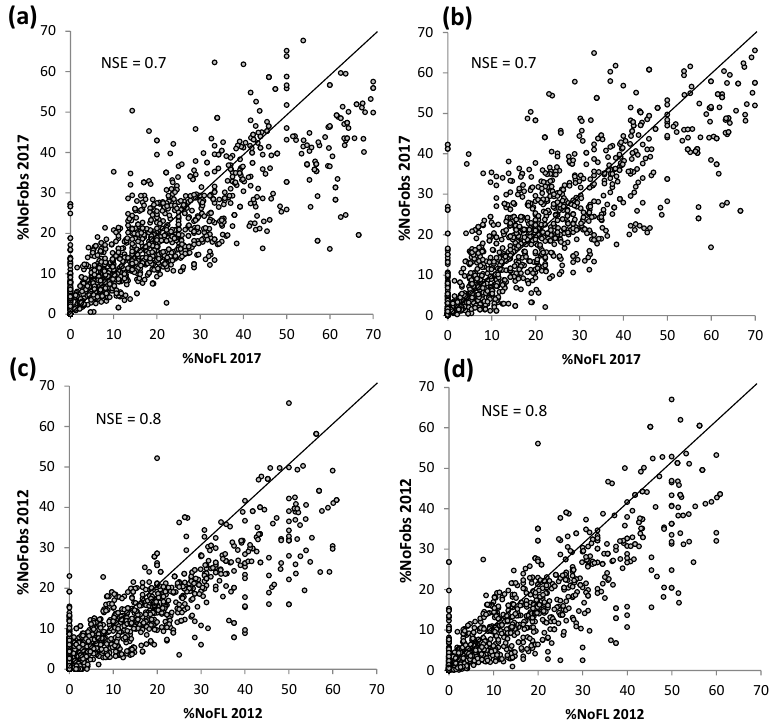
Figure 10. Scatter plot of the predicted RPoD ( x axis) and drying observed at ONDE sites ( y axis) in 2017 and 2012 simulated with the 2011–2017 dataset by ( a and c ) the LLR model and ( b and d ) the LR model.